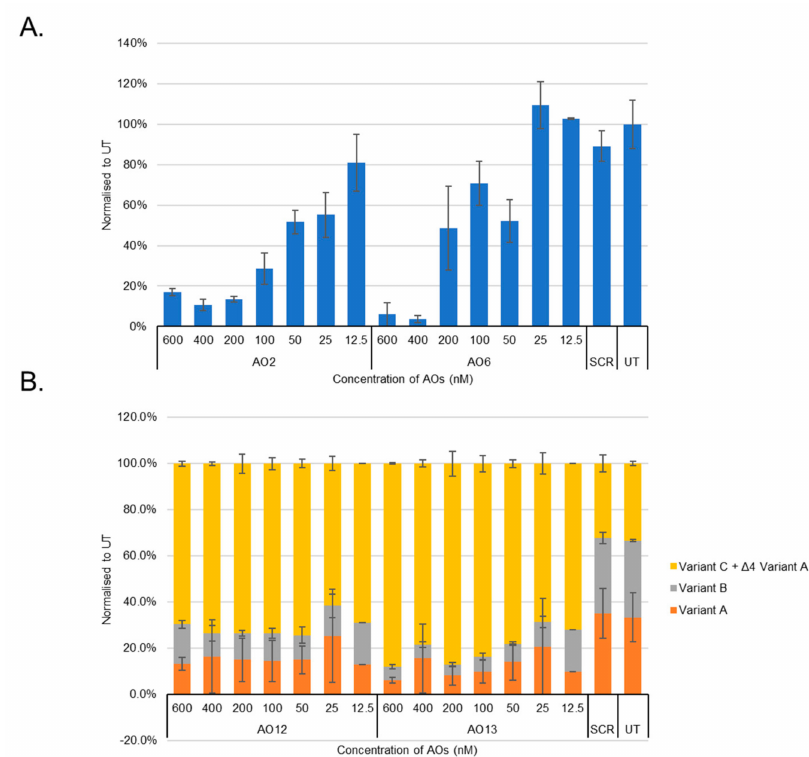
Figure 4. ( A ) Densitometry analysis of RT-PCR products (more than two replicates) using AO2 and AO6 showed downregulation of BACE1 transcript in HEK293 cells in vitro. ( B ) Densitometry analysis of RT-PCR products (more than two replicates) using AO12 and AO13 showed exon-skipping of exon 4 of the BACE1 variant A transcript in HEK293 cells in vitro. Concentrations of AOs used include 12.5nM, 25nM, 50nM, 100 nM, 200 nM, 400 nM, and 600 nM. FL, full-length; UT, untreated; SCR, scrambled